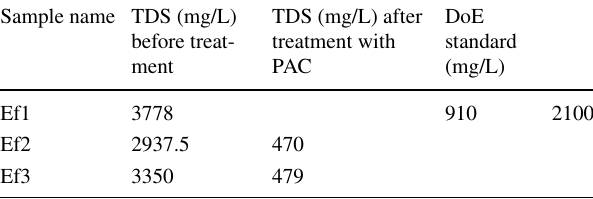
Table 3 Total dissolved solids (TDS) of textile